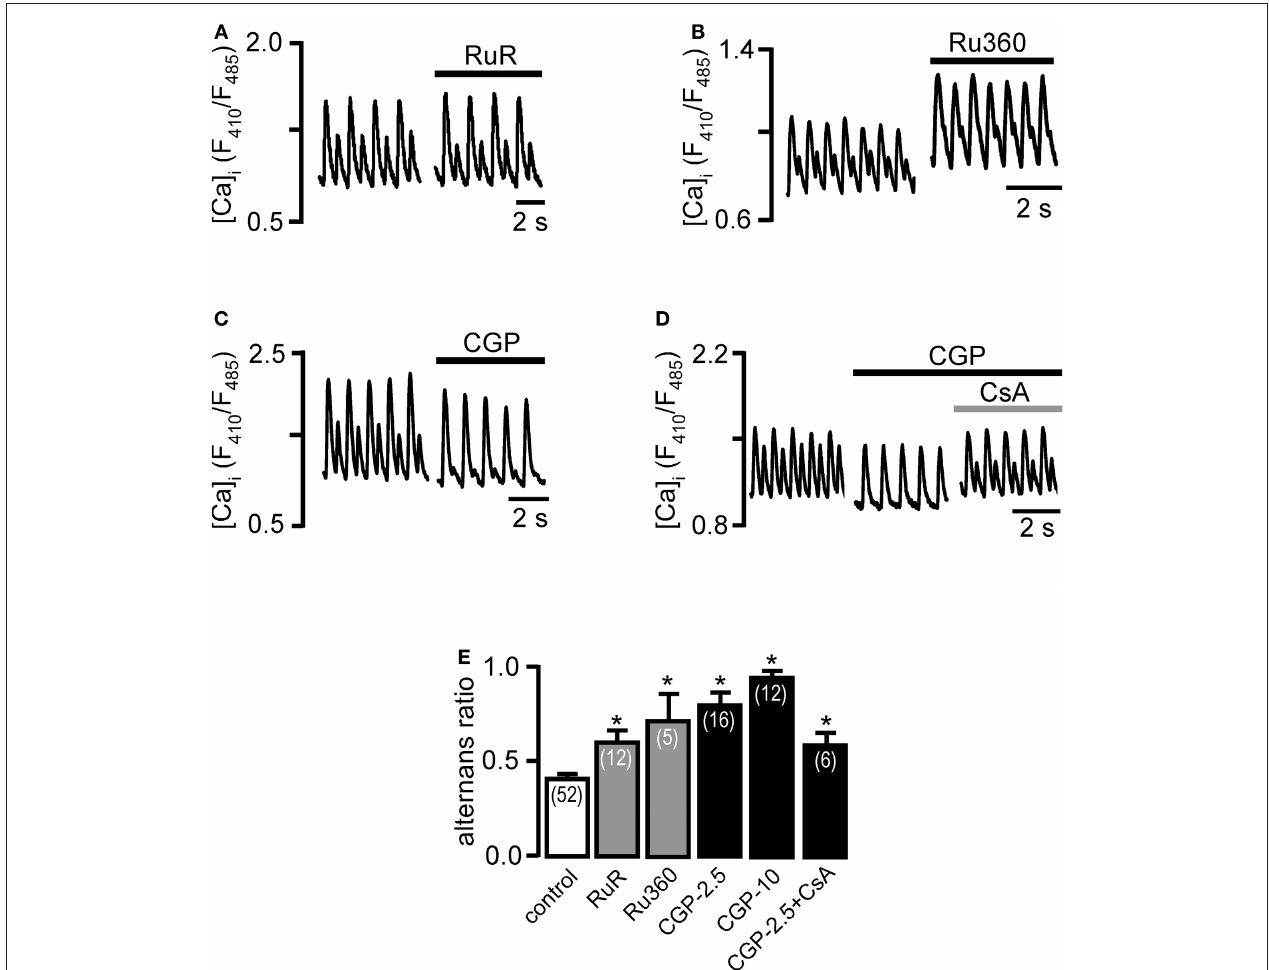
(2.5 μM). (e) Average AR during inhibition of mitochondrial Ca cycling. Numbers in parentheses indicate the number of individual cells tested. *Significantly different from control at P < 0.05. CGP-2.5: 2.5 μM CGP-37157. CGP-10: 10 μM